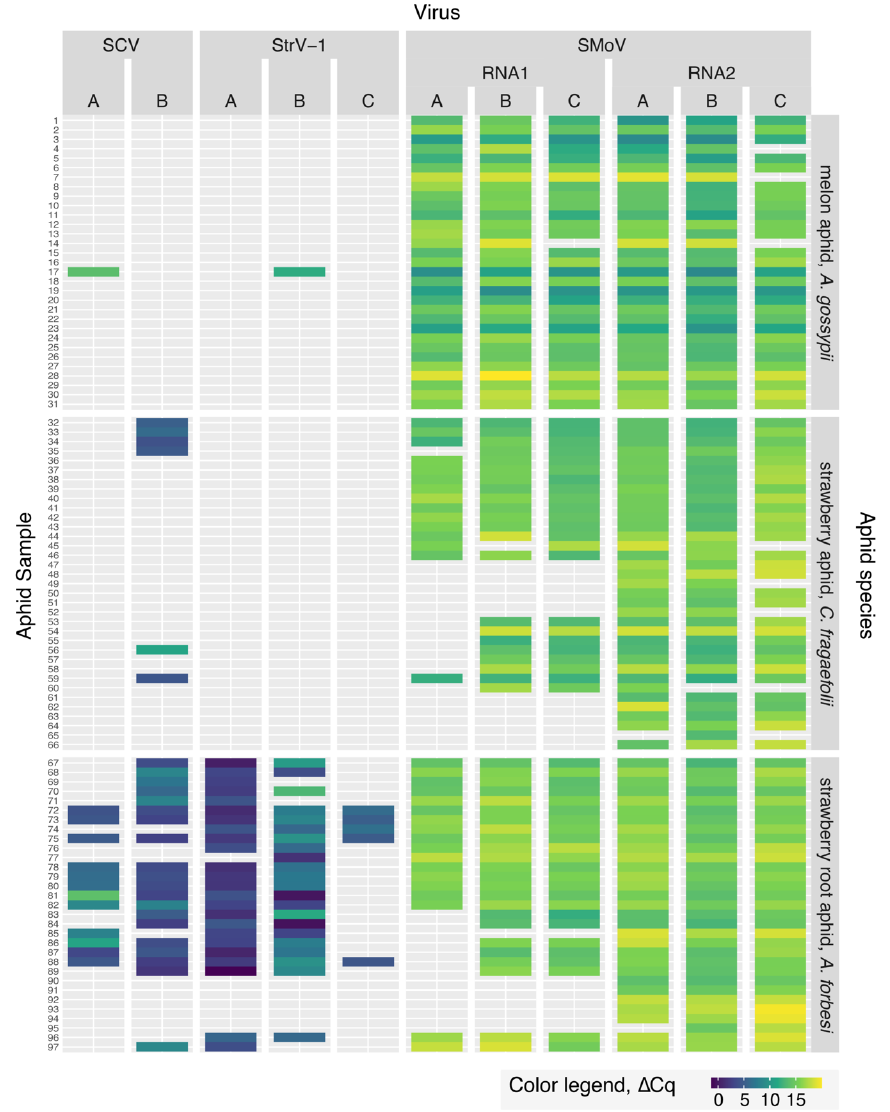
Figure 3. Comparison of ∆ C q values against ratios between negative and positive strands. Cases when only one, negative, strand was detected are annotated by an orange color and were aligned against the n.d. (not detected) sign on the abscissa axis. Using the calculated ∆ C q = 12.5 as a cutoff, the majority of SCV and StrV-1 values for A. gossypii and C. fragaefolii were filtered out (Figure 4; the unfiltered values are available in Table S5).